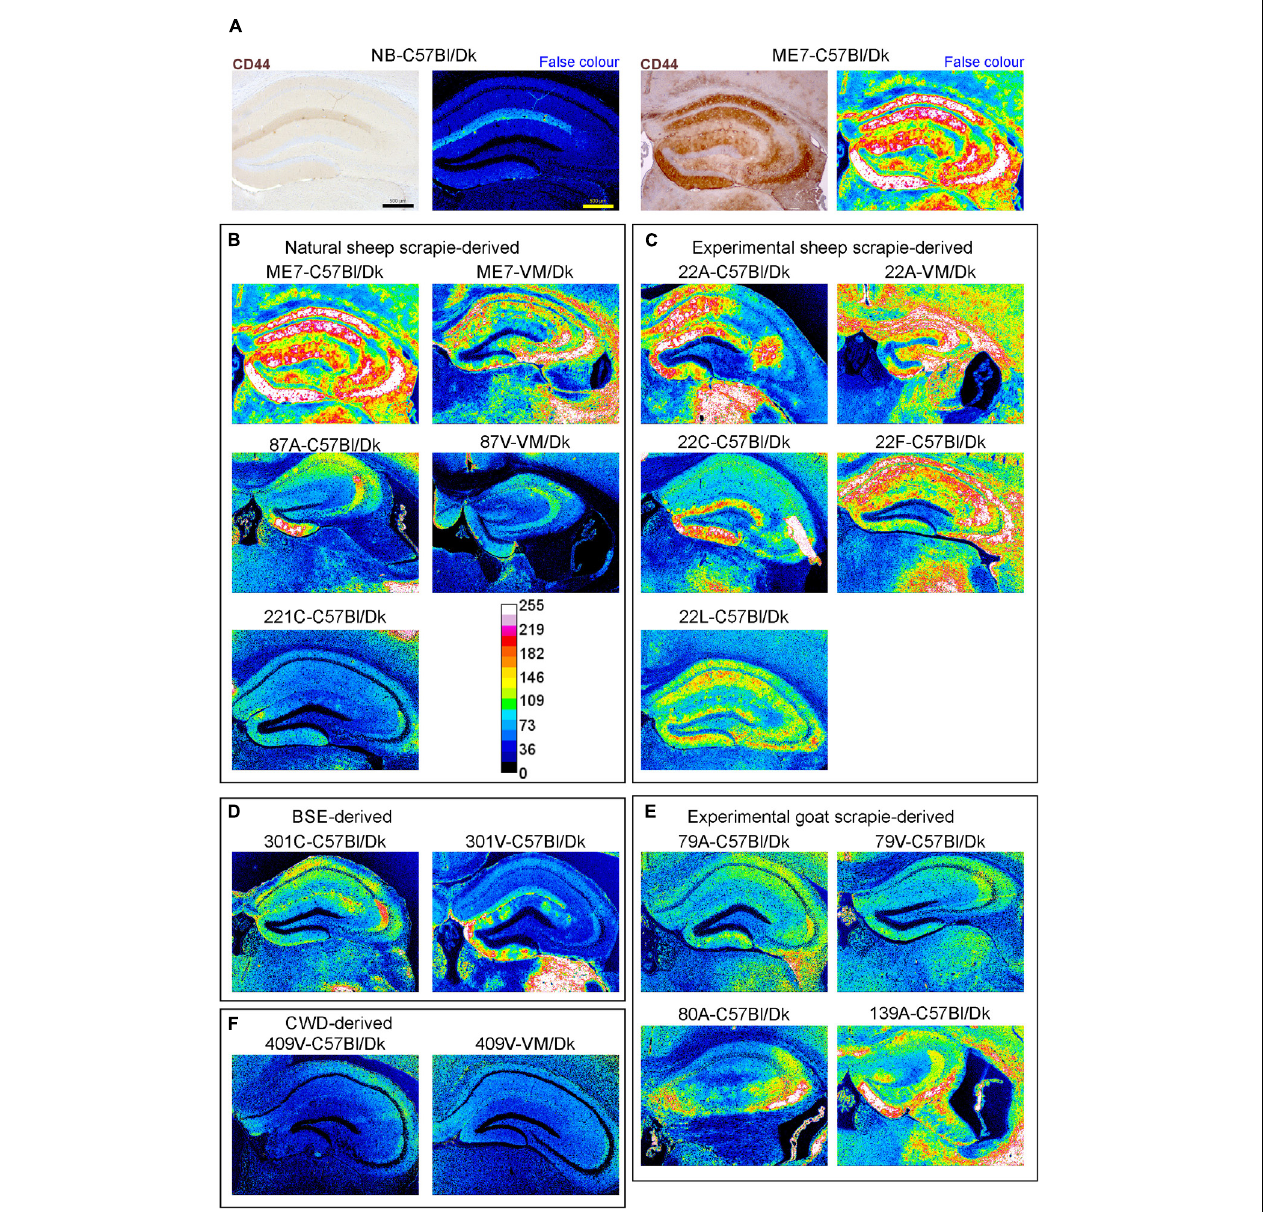
FIGURE 8 | Distinct patterns of CD44 + immunostaining in the hippocampus region of the brains of mice infected with a variety of distinct prion agent strains. Groups of C57Bl/Dk or VM/Dk mice were injected intracerebrally with a variety of distinct prion agent strains ( Table 1 ). Brains were collected at the terminal stage of disease and immunostained to detect CD44. Images were then false-colored to compare the signal intensities of the immunostaining between each group. (A) Normal brain infected mice display little CD44 + immunostaining when compared to mice terminally affected with ME7 scrapie prions. (B–F) Comparison of false colored images to show the variation in CD44 + immunostaining between diverse prion strains isolated from a variety of sources. Representative images from 6 mice/group are shown. Scale bars = 500 µ